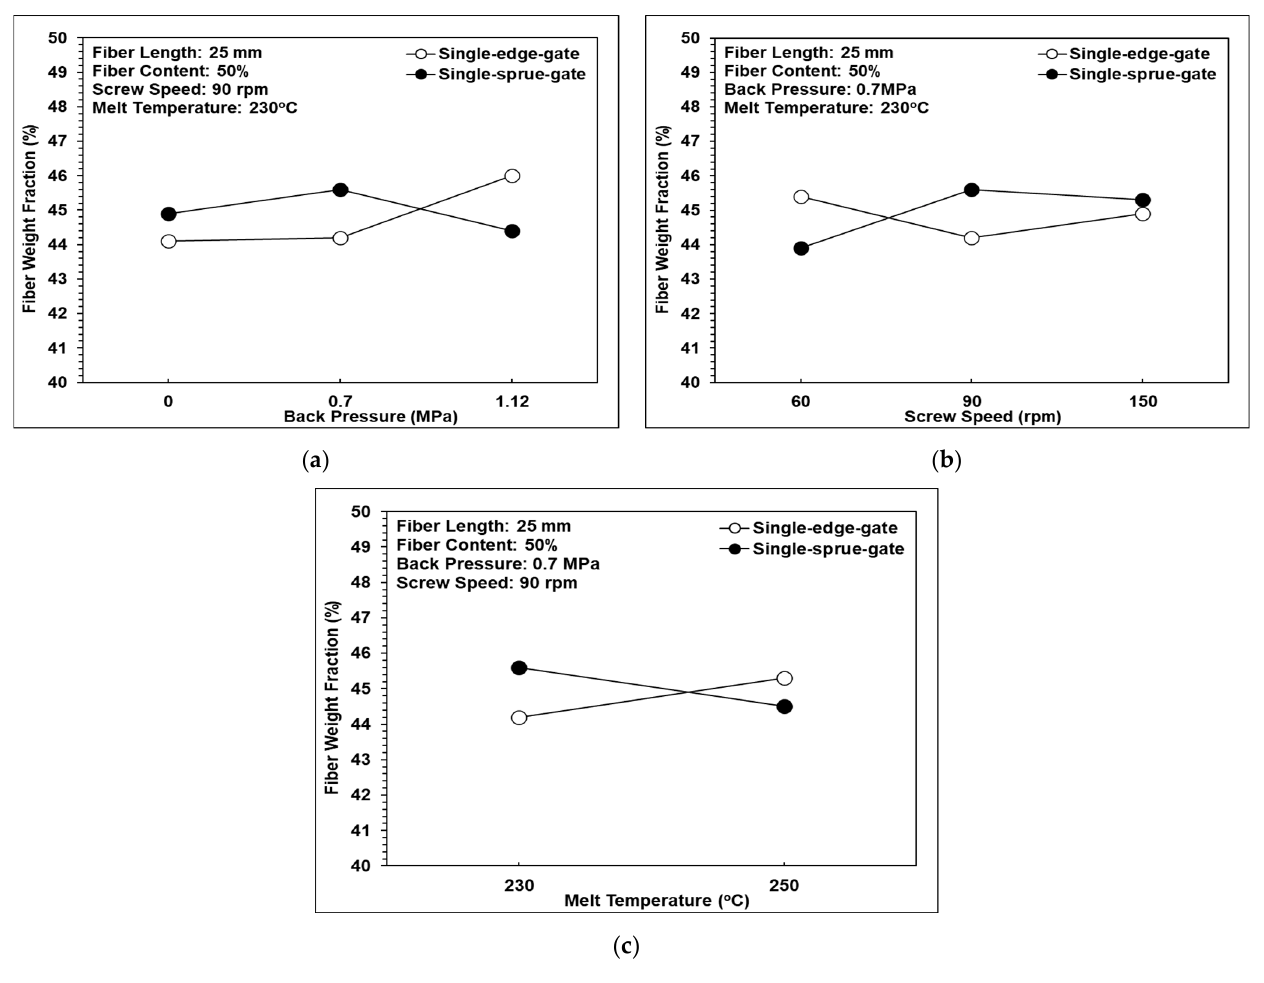
Figure 14. Effects of the different melt flow paths on the fiber weight fraction: ( a ) back pressure variations, ( b ) screw speed variations, and ( c ) melt temperature variations.